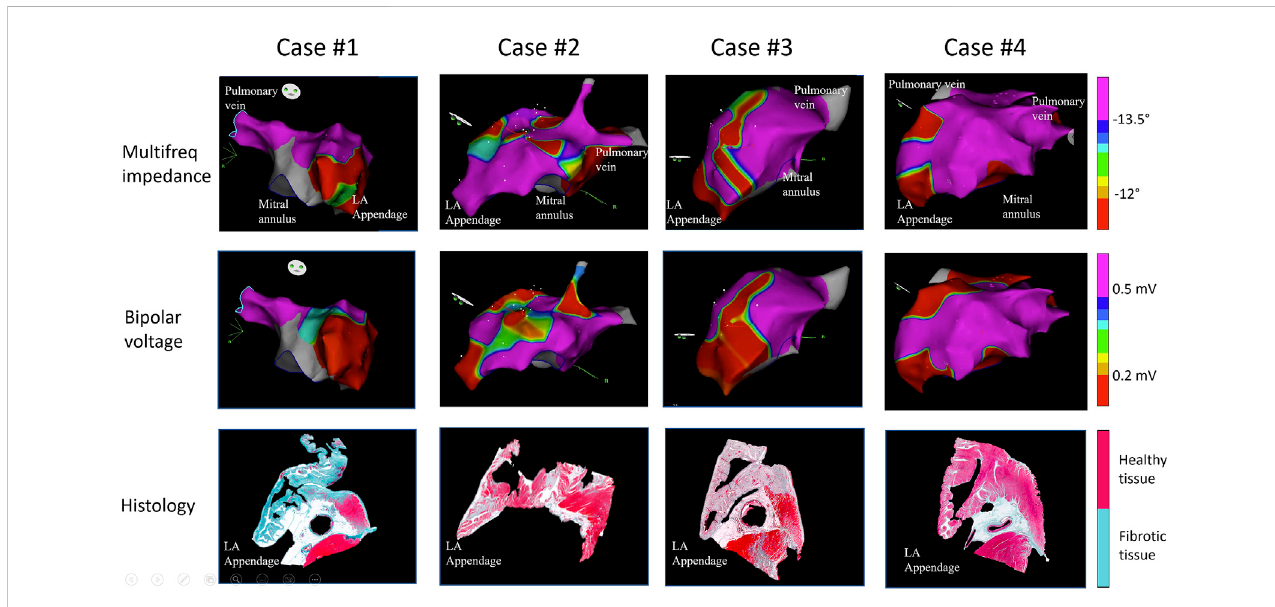
FIGURE 2 Electroanatomical voltage and multifrequency impedance maps of the left atrium and histological preparations of the explanted hearts of four representative pigs submitted to acute transcatheter occlusion of the atrial coronary artery branches arising from the proximal segment of the left circum fl ex coronary artery, with preserved left ventricular myocardium. The fi gure shows a correspondence between endocardial areas of low voltage and impedance and location of infarct